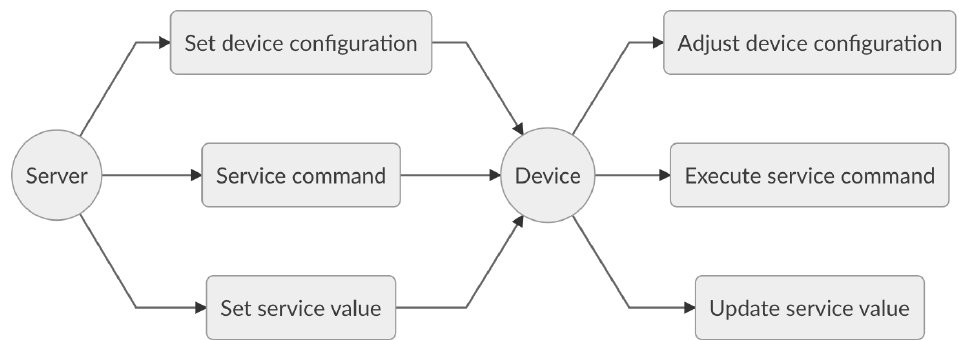
Figure 4. Device functional